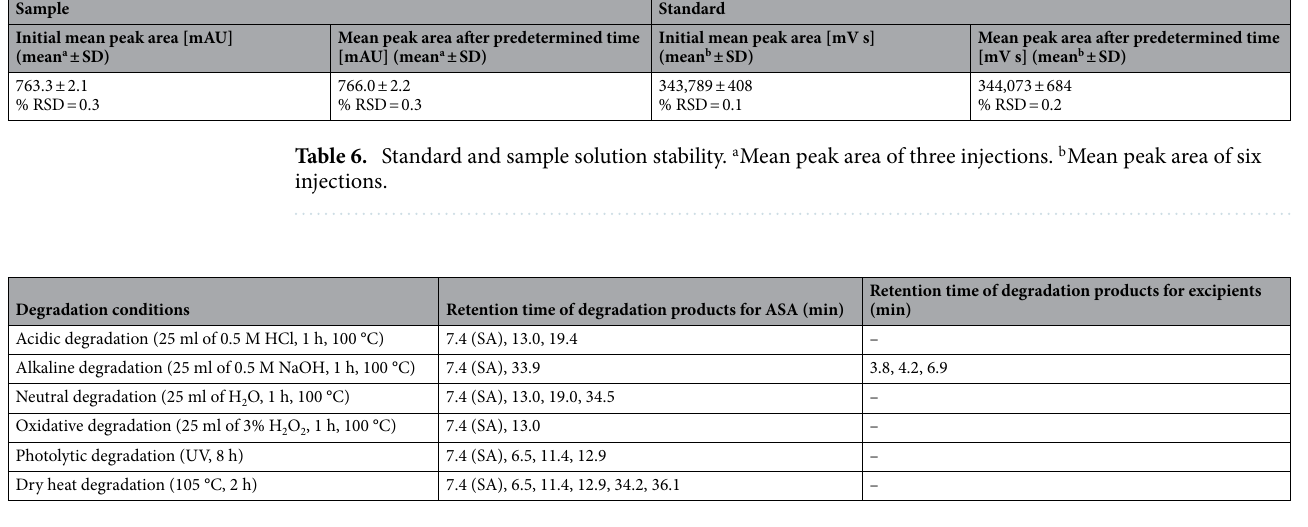
Table 7. Summary of degradation studies of ASA and